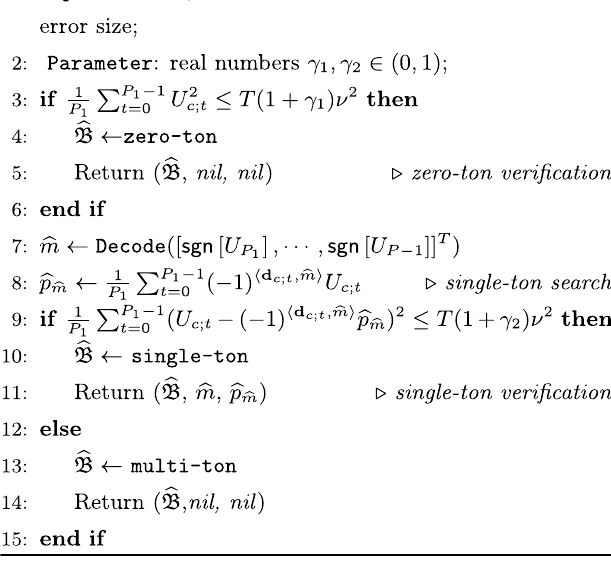
Algorithm 4. Bin Detector: BD ( U c , D c , T )